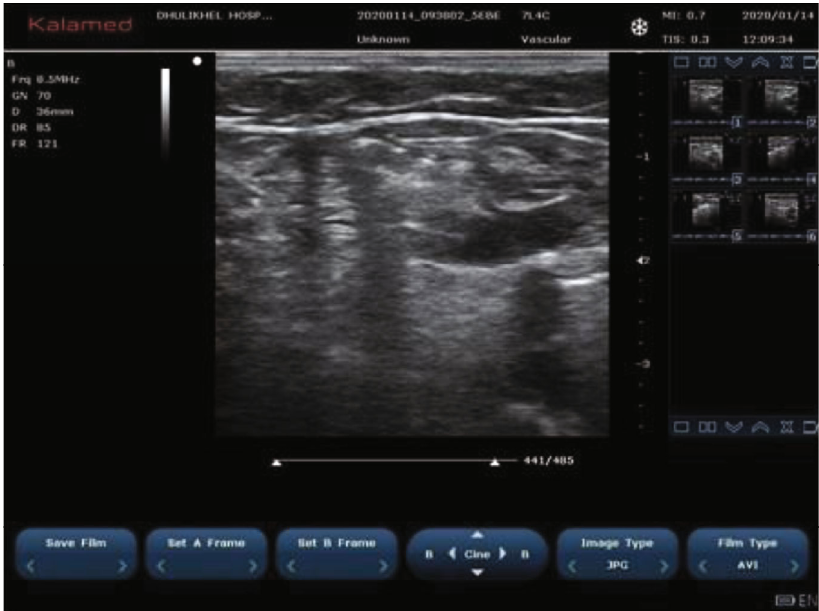
Figure 11: Increase in distance of instillation of normal